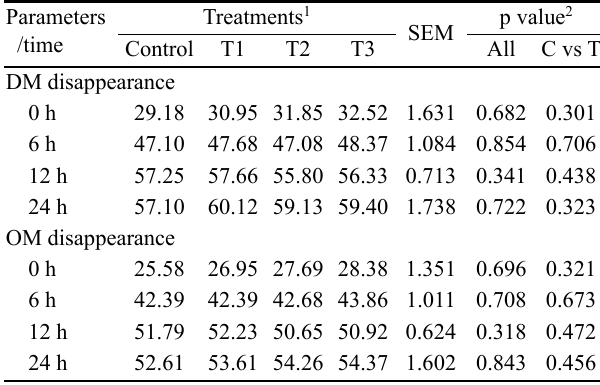
SEM, standard error of the mean; DM, dry matter; OM, organic matter. 1 Control: without lysozyme, T1: 2,000 unit lysozyme, T2: 4,000 unit lysozyme, T3: 8,000 unit lysozyme. 2 C vs T is the comparison between control and treatment. Means in the same row with different superscript are significantly different (p<0.05).